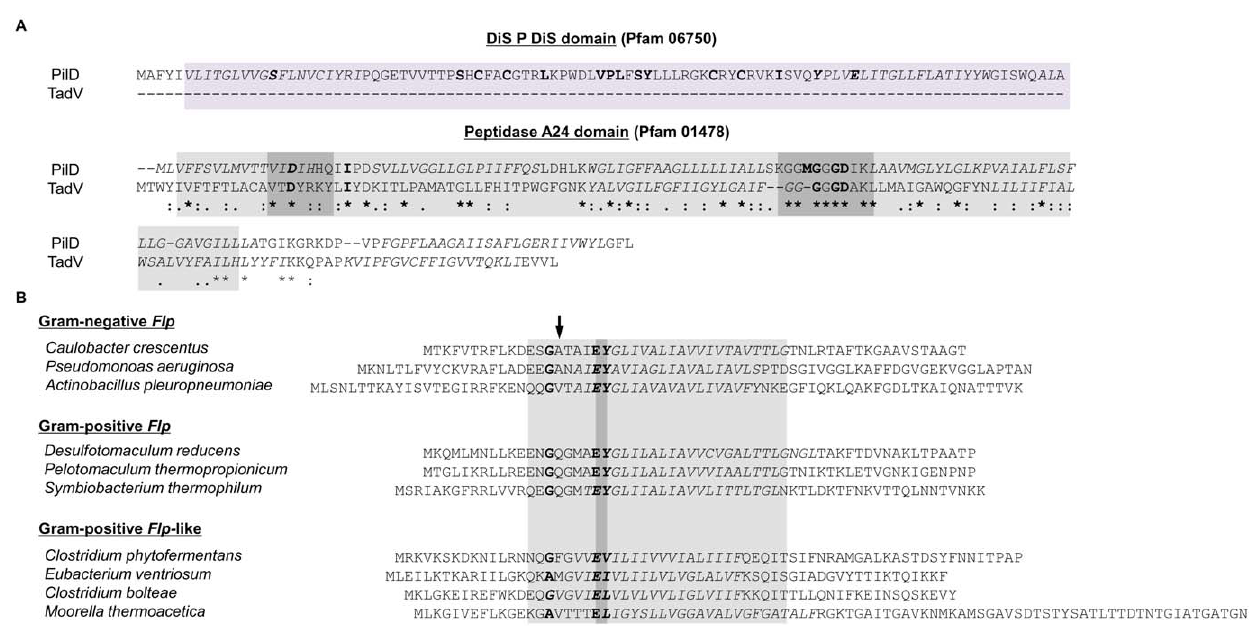
Figure 2. Alignment of PilD/TadV peptidases and Flp pilin signal peptides from Gram-negative and Gram-positive bacteria. ( A ) ClustalW alignment of PilD and TadV sequences from the Gram-positive bacterium D. reducens , including the N-terminal Dis P Dis domain (purple shading) characteristic of PilD/ComC homologs and the Peptidase A24 domain (light grey shading) found in both PilD/ComC and TadV homologs. Darker shading indicates predicted peptidase active sites, including the two essential aspartates (D). ( B ) Alignment of Gram-positive and negative pilins highlighting the Flp motif (shading), conserved TadV cleavage site (arrow), glutamate (E) at + 5, and tyrosine (Y) at position + 6 in Flp pilins (diverged in Flp-like pilins). Hydrophobic stretches (italics) were predicted by Phobius [28].